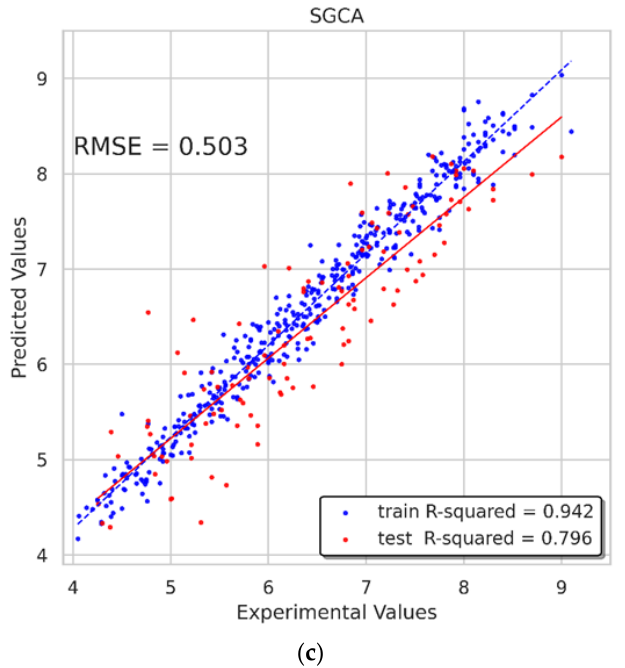
Figure 10. Results of three multi-GNN models. ( a ) Result of GIAN model; ( b ) Result of GIAT model; ( c ) Result of SGCA model.